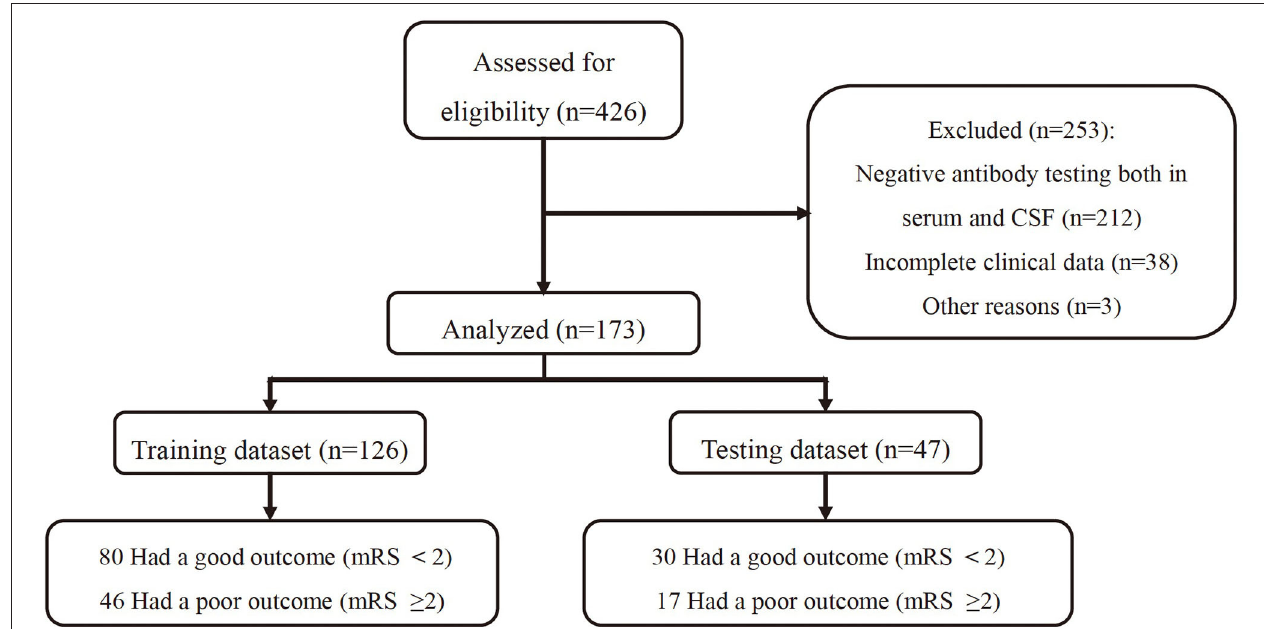
FIGURE 1 | Numbers of participants enrolled and outcomes in the training and validation data sets.